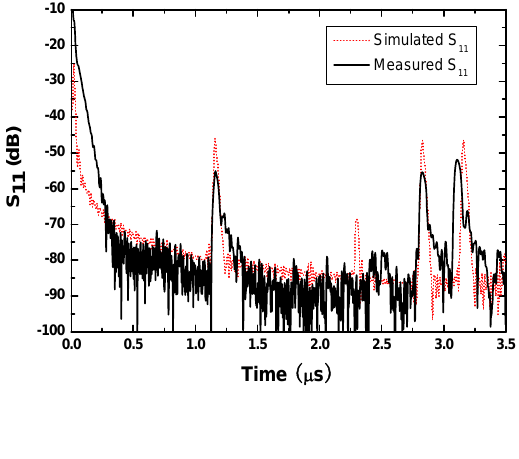
Figure 8. Comparison between the measured S delay